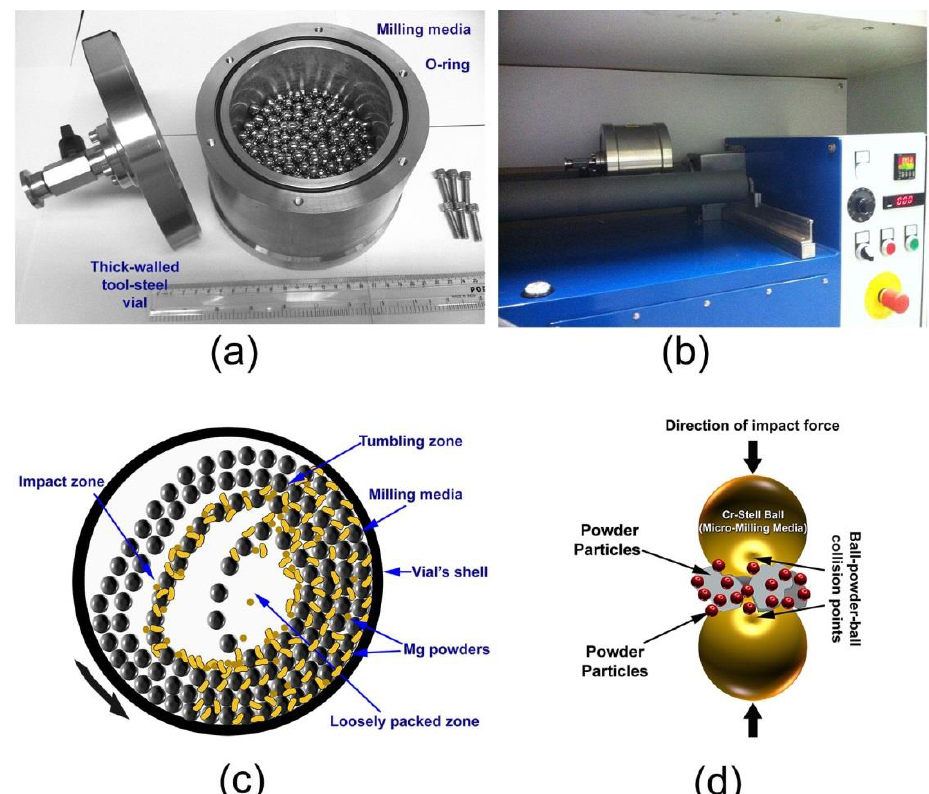
Figure 6. Photographs from NAP, EBRC, and KISR demonstrate a laboratory-scale 1 L roller mill setup. ( a ) The milling tools, which include the balls and vial, ( b ) The ball milling process, which utilizes a roller mill, ( c ) Schematic representations of ball positions and movement inside the vial of a tumbler mall mill operating in dynamic mode, and ( d ) A typical ball-powder-ball collusion during a low energy tumbling process.